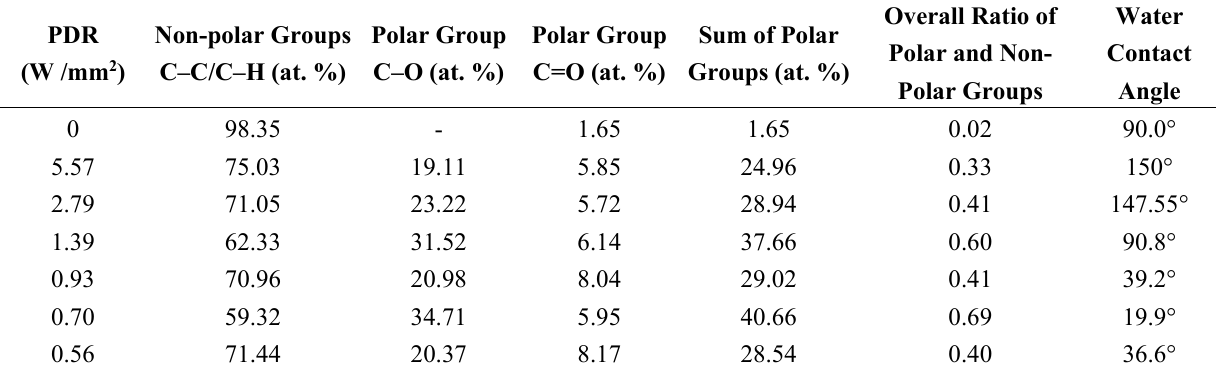
Figure 6. X-ray photoelectron spectroscopy (XPS) spectra of ( a ) pristine COP surface and ( b ) COP surface treated with a PDR of 2.79 W/mm 2 at a fixed fluence of 26.39 J/cm 2 . Table 1. Polar and non-polar groups formed on the COP surface before and after laser treatment at a fixed laser fluence of 26.39 J/cm 2